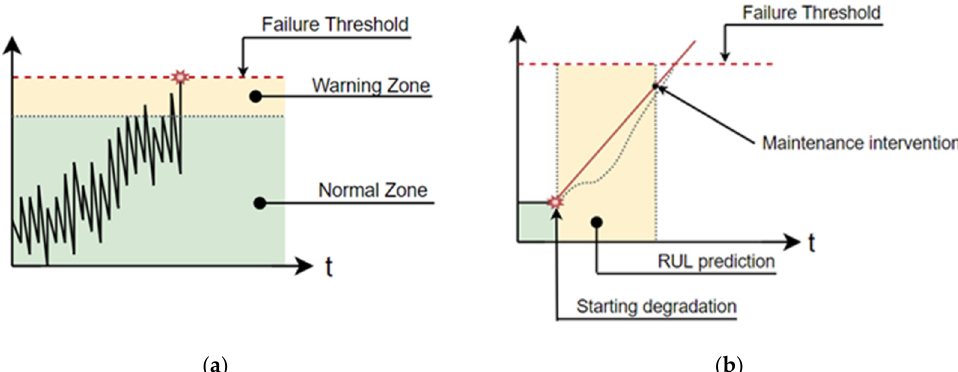
Figure 1. ( a ) Condition-Based Maintenance (Diagnostic) (based on [3]); ( b ) Predictive Maintenance (Prognostic) (based on [12]) .